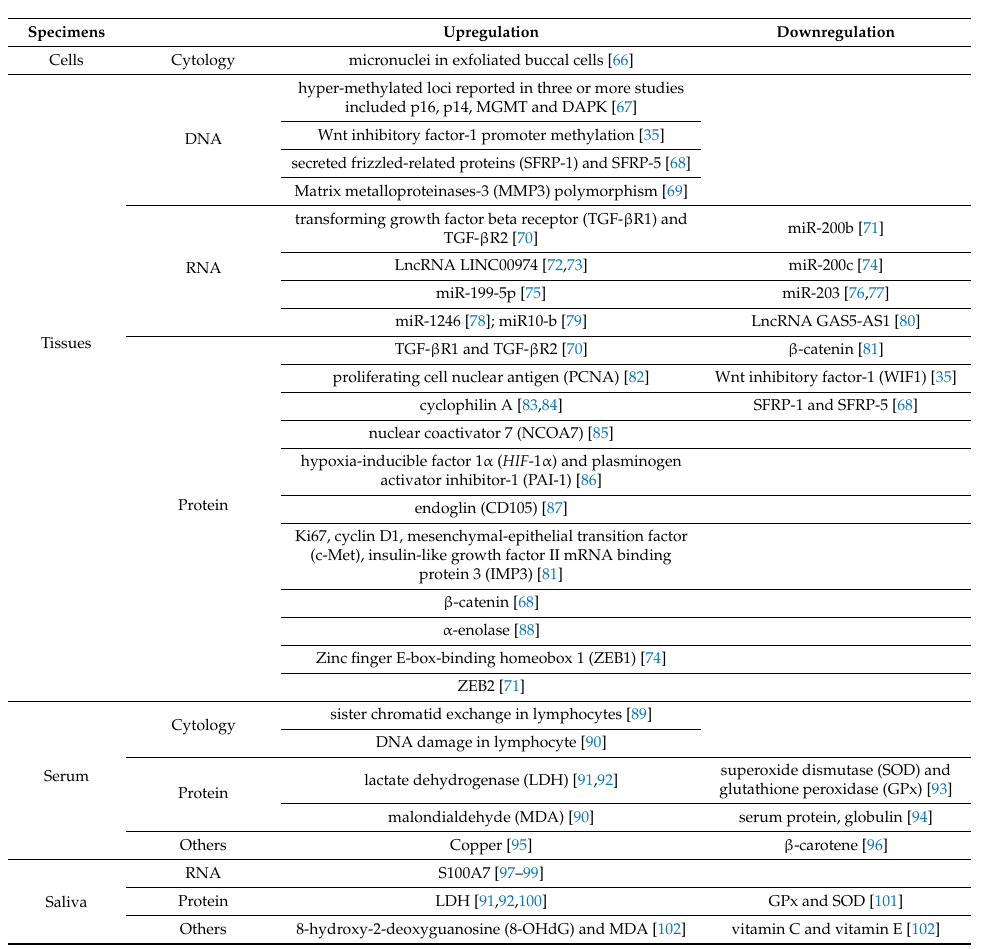
Table 3. Biomarkers in OSF